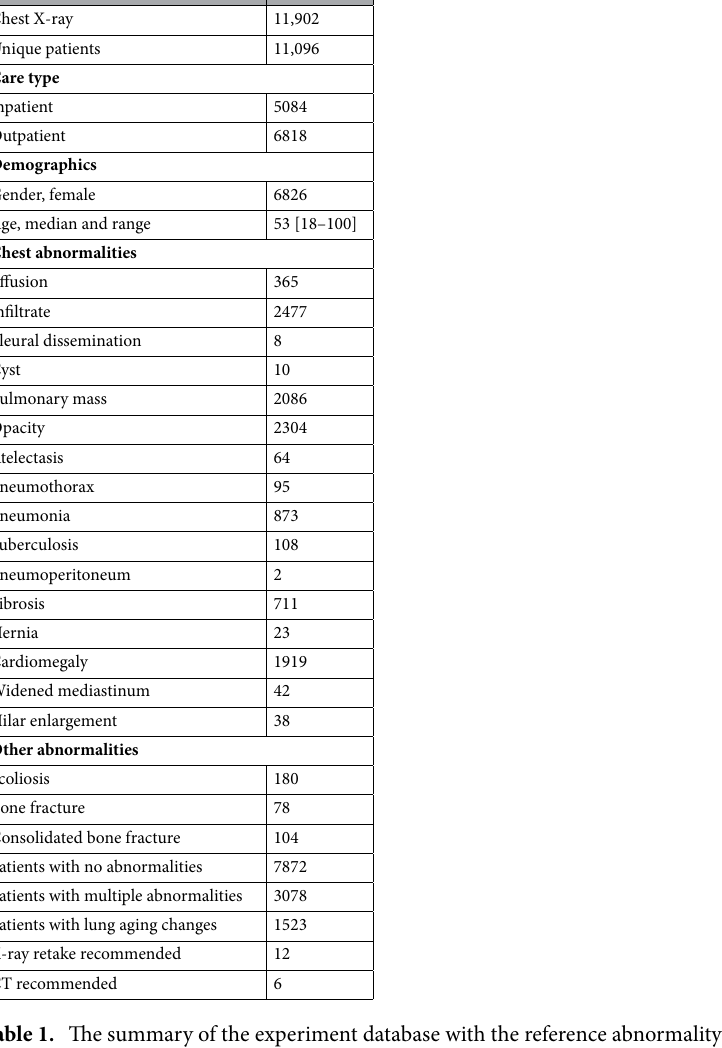
Table 1. The summary of the experiment database with the reference abnormality